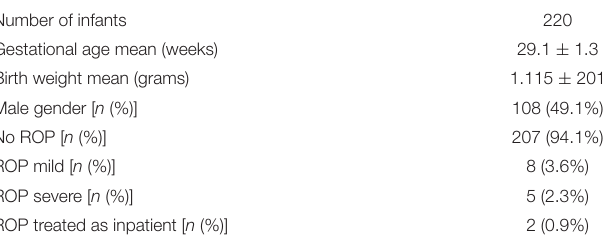
TABLE 1 | Patient characteristics and rates of ROP. Number of infants